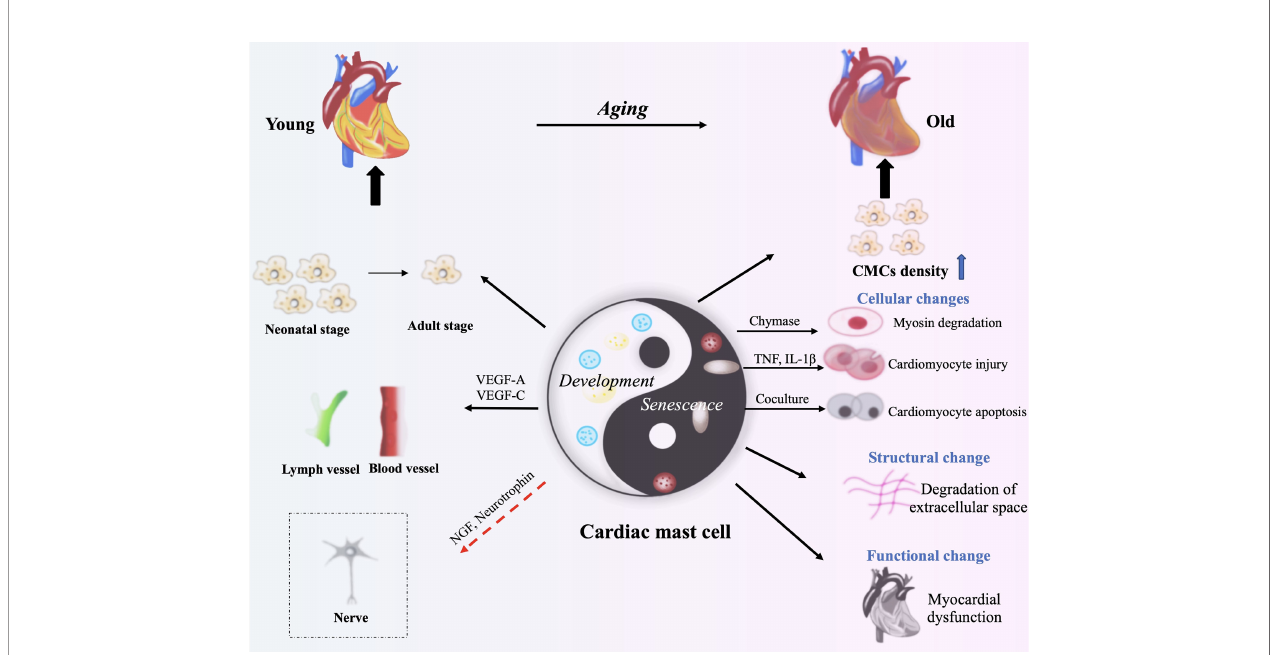
FIGURE 2 | The roles of CMCs in cardiac development and aging. VEGF-A, VEGF-C, NGF and neurotrophin from CMCs contribute to cardiac development through bene fi ting the formation of blood vessels and lymphatic vessels, and the development of cardiac nerves (neonatal stage). CMCs produce Chymase, TNF and IL-1 b to degrade myosin or to damage cardiomyocytes. CMCs ’ activation following cardiac injury causes in fl ammatory response, and then lead to the structural damage and cardiac dysfunction (Old Stage). The red arrow means